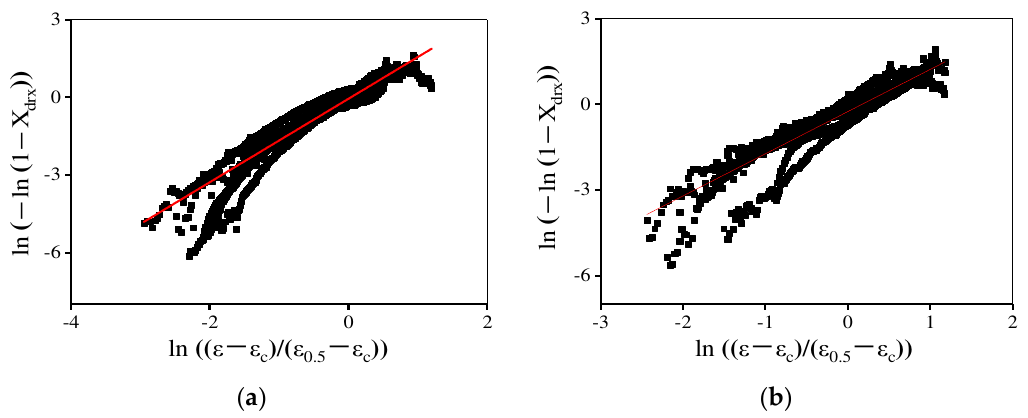
Figure 16. The relationship between ln ( − ln ( 1 − X drx )) and ln (( ε − ε c ) / ( ε 0.5 − ε c )) at ( a ) 1080–1120 ◦ C and ( b ) 1120–1170 ◦ C. Figure 17 gives the variations in the calculated X drx with the strain. Also, the comparisons between the calculated and experimental X drx are represented. The calculated values are very close to the experimental ones. To confirm the precision of the proposed piecewise DRX kinetics equations, R and AARE are calculated. The AARE value is 2.3% and the R value is 0.992. Hence, the DRX behavior of the present HIPed P/M superalloy during hot compression can be accurately described by the proposed piecewise DRX kinetics equations.